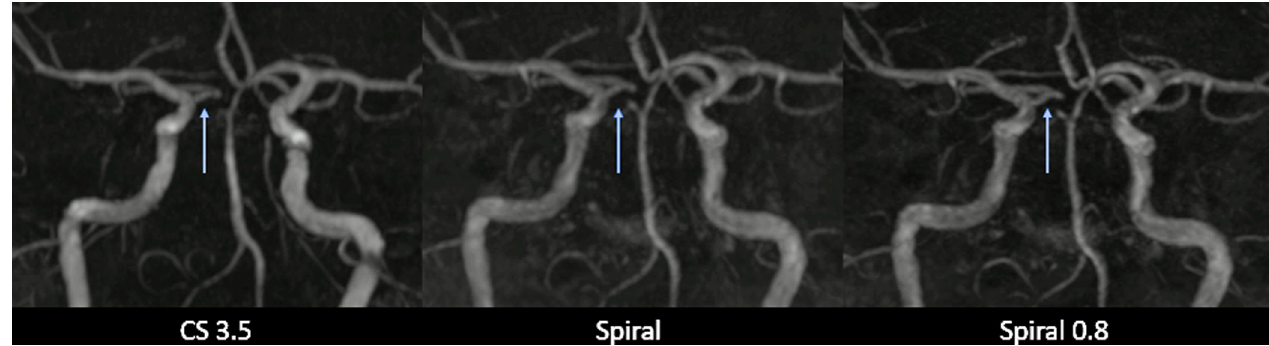
Fig 7. MIP images showing an embryonic posterior cerebral artery with missing P1 segment of the posterior cerebral artery on the right side.